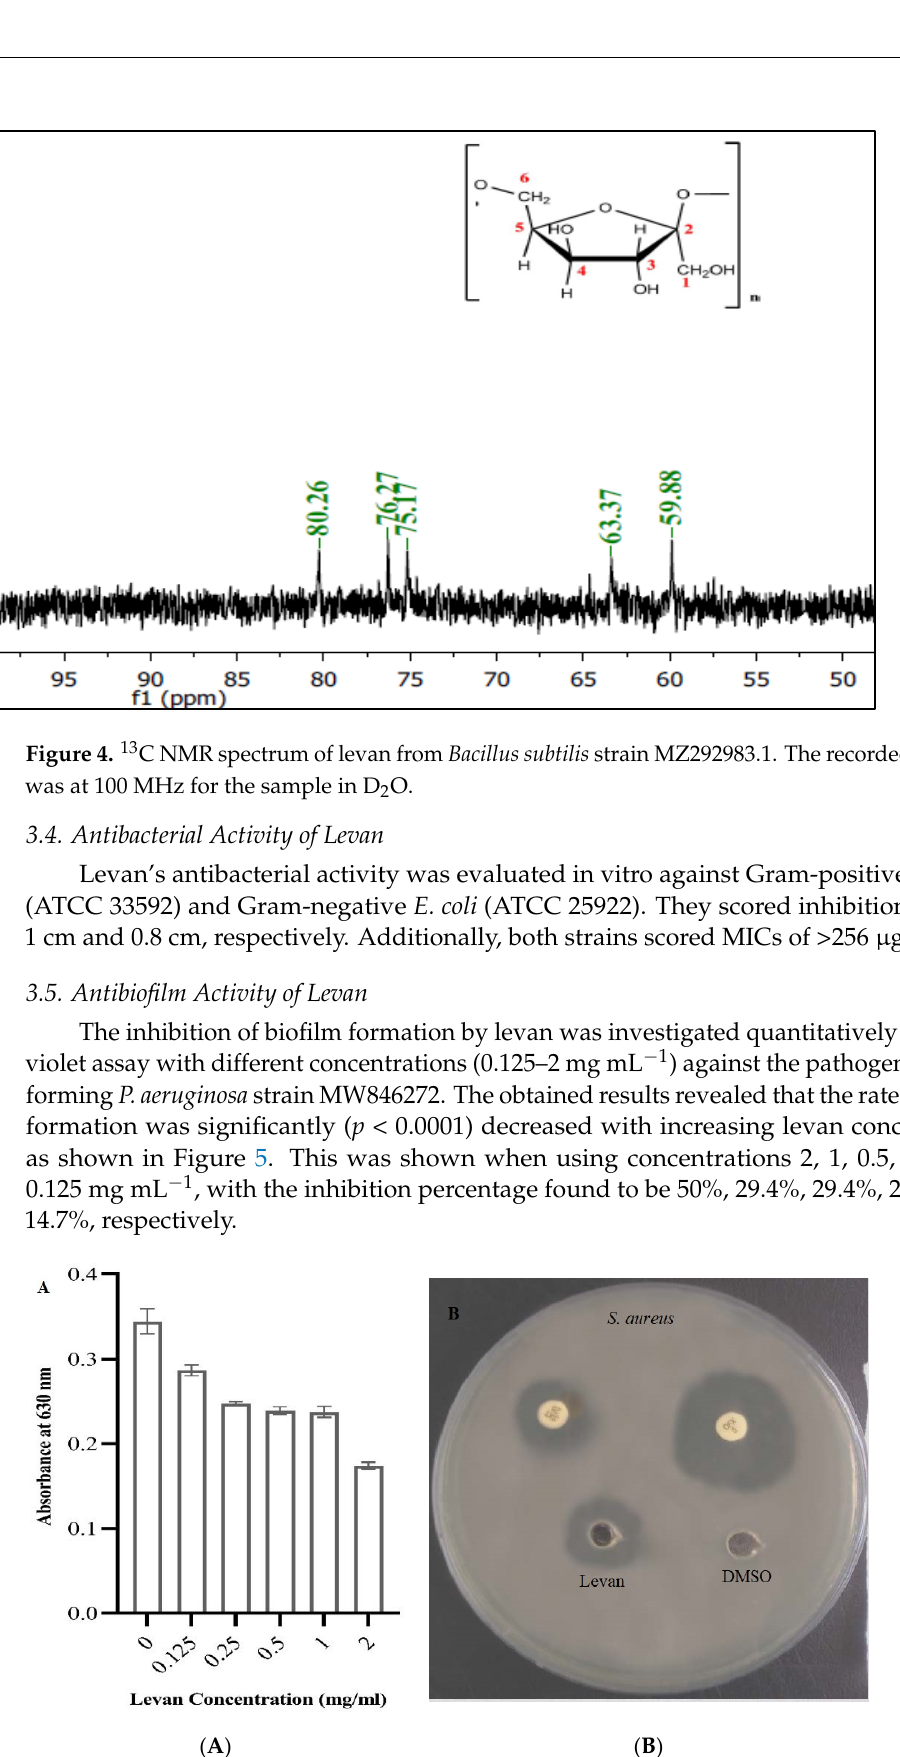
Figure 3. 1 H NMR spectrum of levan from Bacillus subtilis strain MZ292983.1. The recorded spectrum was recorded at 400 MHz for the sample in D 2 O.